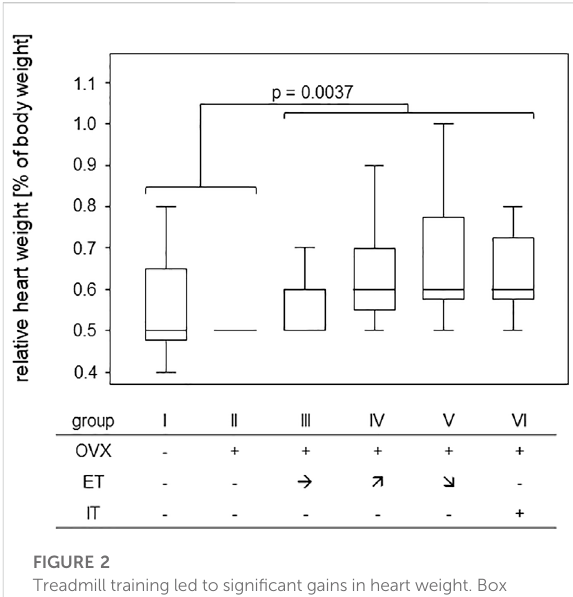
FIGURE 2 Treadmill training led to signi fi cant gains in heart weight. Box plots show the ratios of heart to body weight for the various training groups. Comparison between untrained (groups I and II) and trained groups (groups III-VI) was performed via Mann- Whitney U-Test and statistically signi fi cant difference is indicated by the p